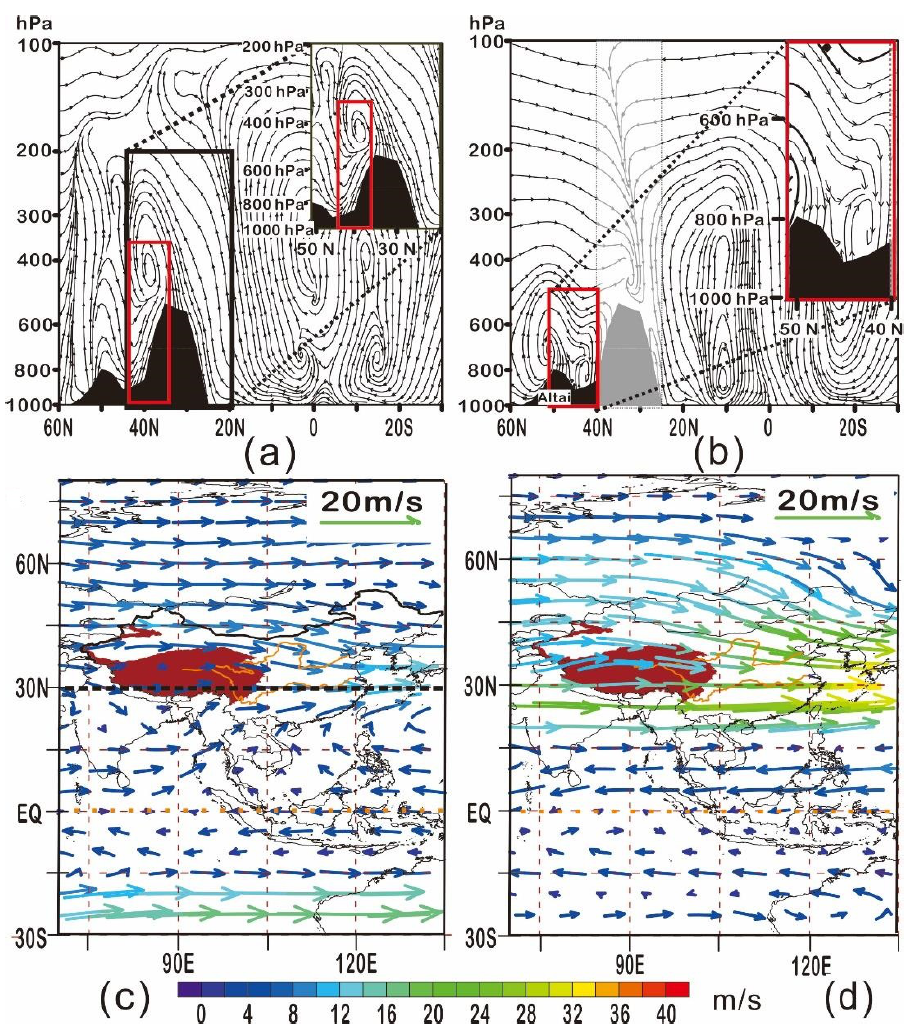
Figure 3. Wind fields. ( a ) Mean meridional circulation at 90° E in June. ( b ) Mean meridional circulation at 90° E in January. ( c ) Wind field at 500 hPa in June. ( d ) Wind field at 500 hPa in January. The red rectangles ( a , b ) represent the intersection of the updraft and the downdraft. The grey area in part ( b ) represents the Tibetan Plateau area.